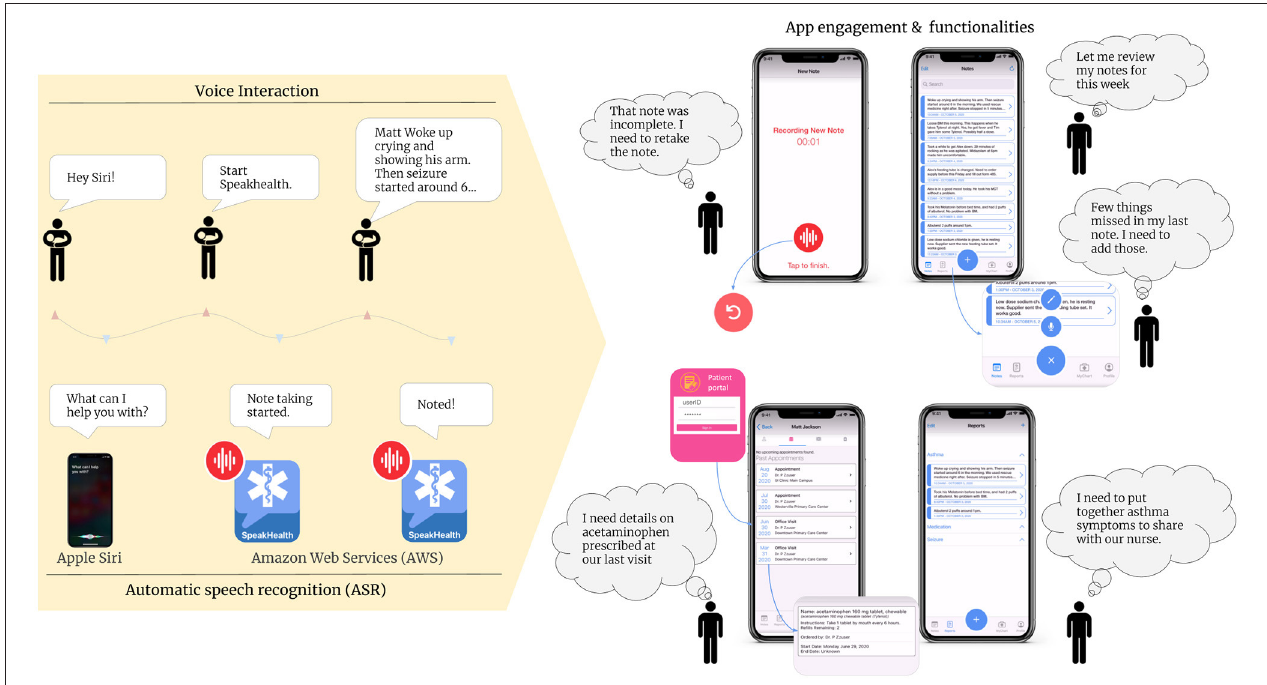
FIGURE 1 | Voice interaction, ASR, and app